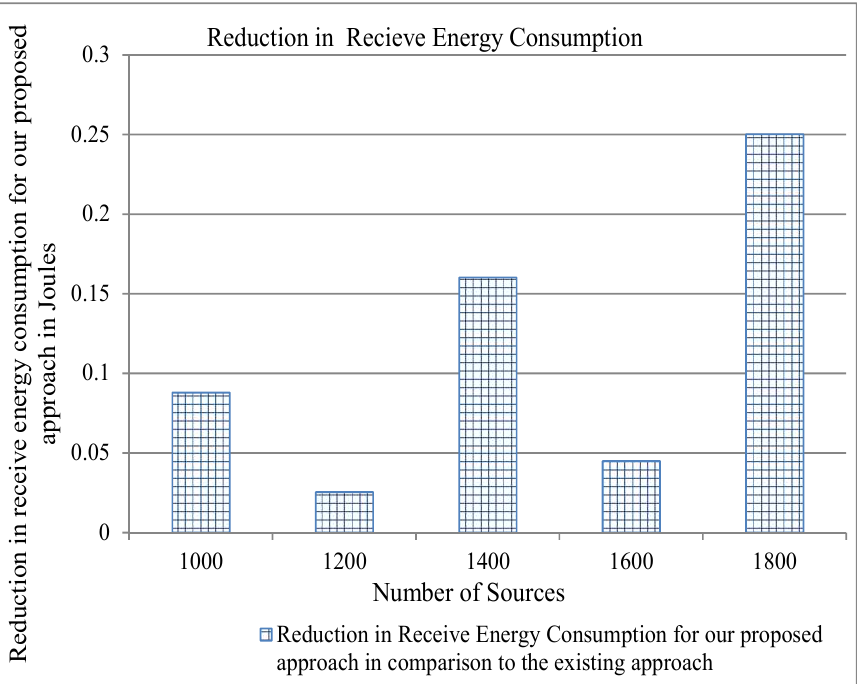
Figure 7. Reduction in Transmission Energy for our proposed approach in comparison to the existing for two cache servers.